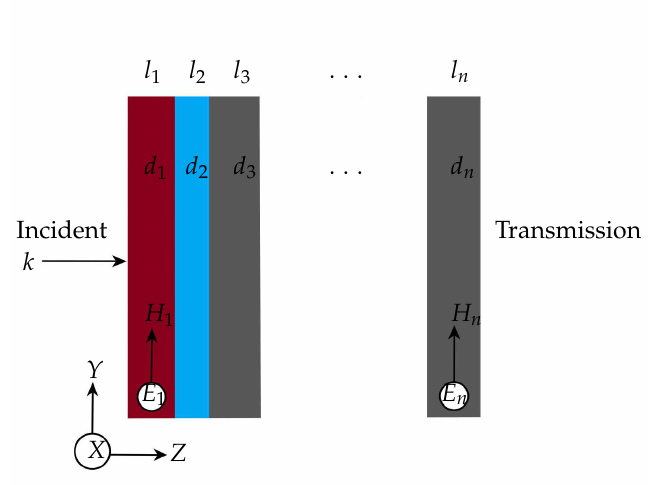
Figure 3. Schematic diagram for 1D multi-layered thin-film structure where magnetic field lies on incident plane, a plane wave propagating in wave vector k direction with layer thicknesses d i for layers l i , i ∈ { 1, . . . , n }